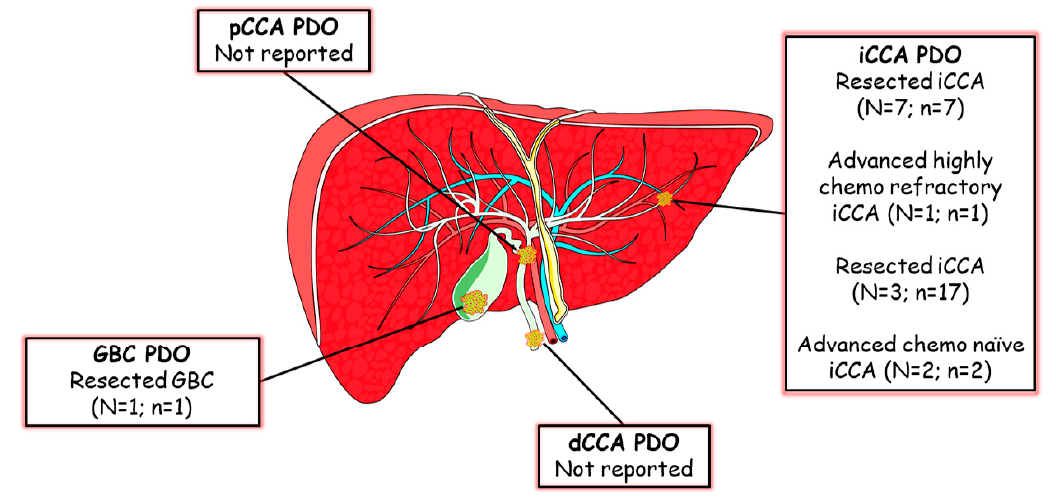
Figure 2. Patient derived organoid (PDO) lines from biliary tract malignancies. Graphic representation of four types of biliary tract malignancies with relative PDO lines generated so far for GBC [5] and iCCA (from top to bottom of the box [4,5,14], [32], [35], [36]). (N: number of patients; n: number of PDO